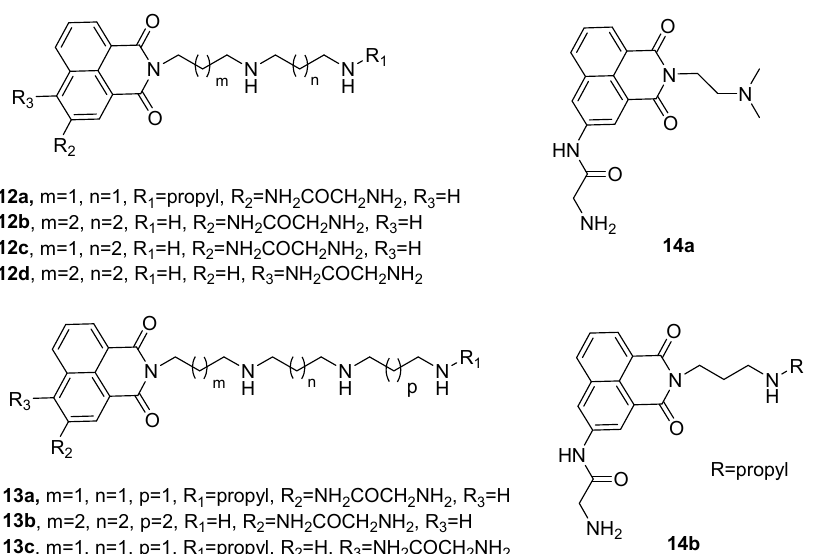
Figure 12. Chemical structures of the naphthalimide ‐ polyamine conjugates, 12a – d , 13a – c and 14a – b [74]. 14a – b [74].